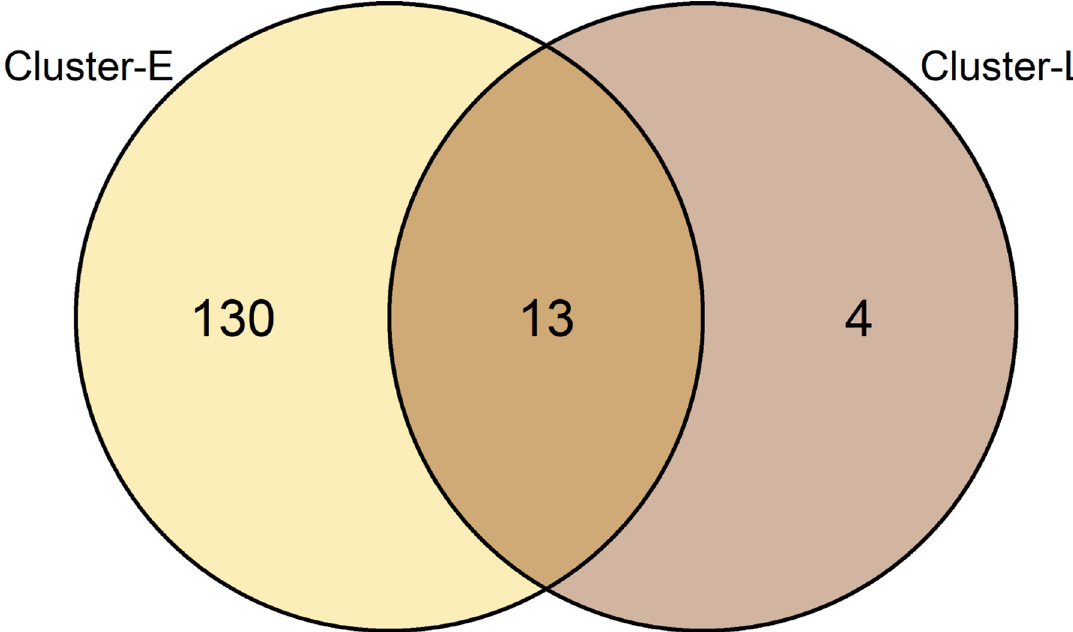
Fig 2. Venn diagram of OTUs in Cluster-E and Cluster-L from cluster analysis. The name of clusters corresponds to descriptions in Figs 1B and S3B.